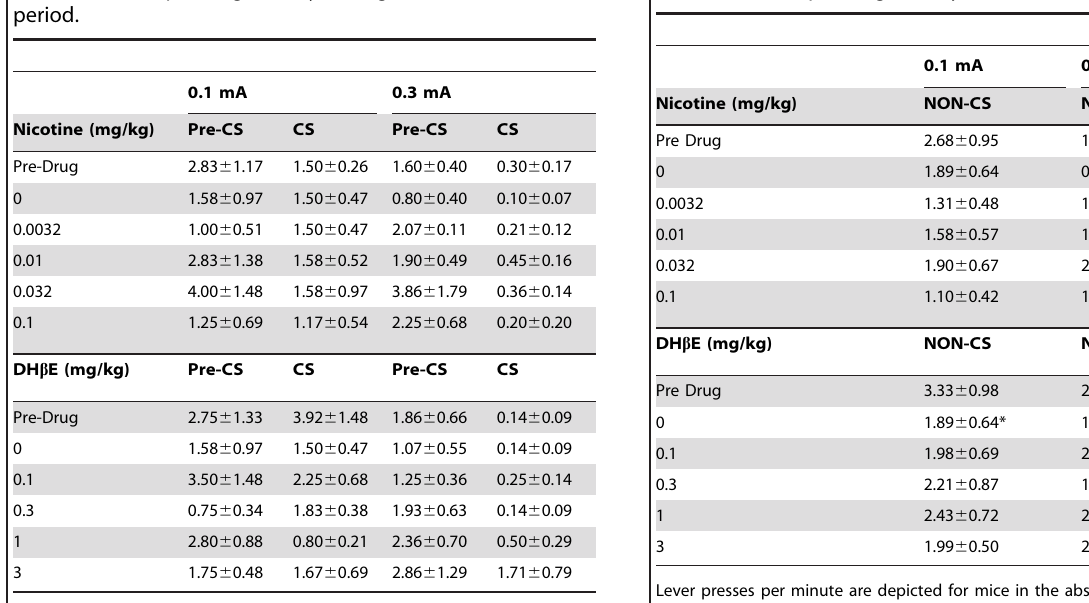
Table 2. Lever pressing activity in the absence of the